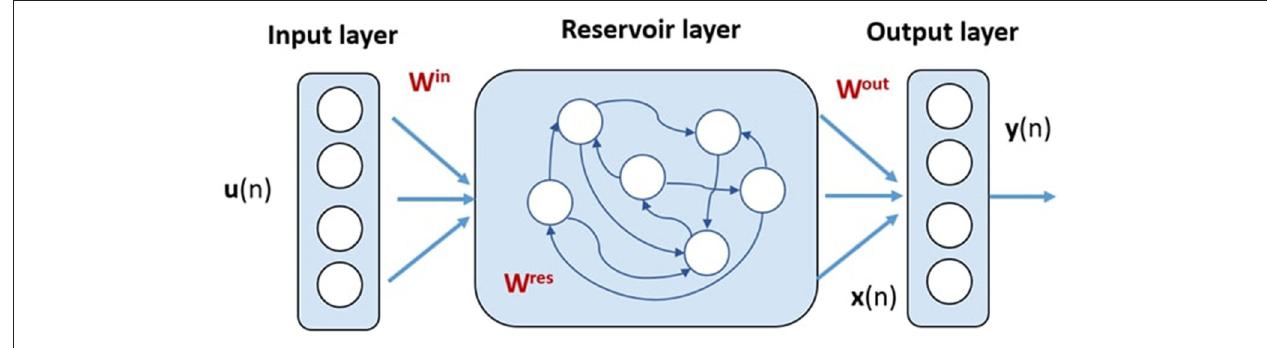
FIGURE 2 | Echo state network structure comprising an input layer, a reservoir layer, and an output layer. Only the W res weights are subject to learning.